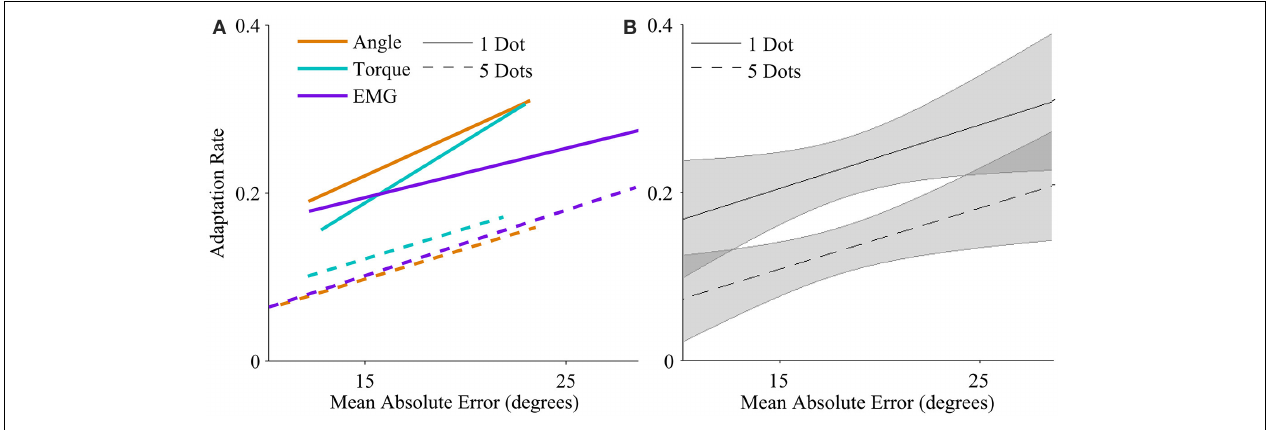
FIGURE 3 | Adaptation rate as a function of mean absolute endpoint error. (A) Regression between adaptation rate and error with each control interface, for low feedback uncertainty (solid lines), and high feedback uncertainty (dashed lines). The range of each regression line runs from the